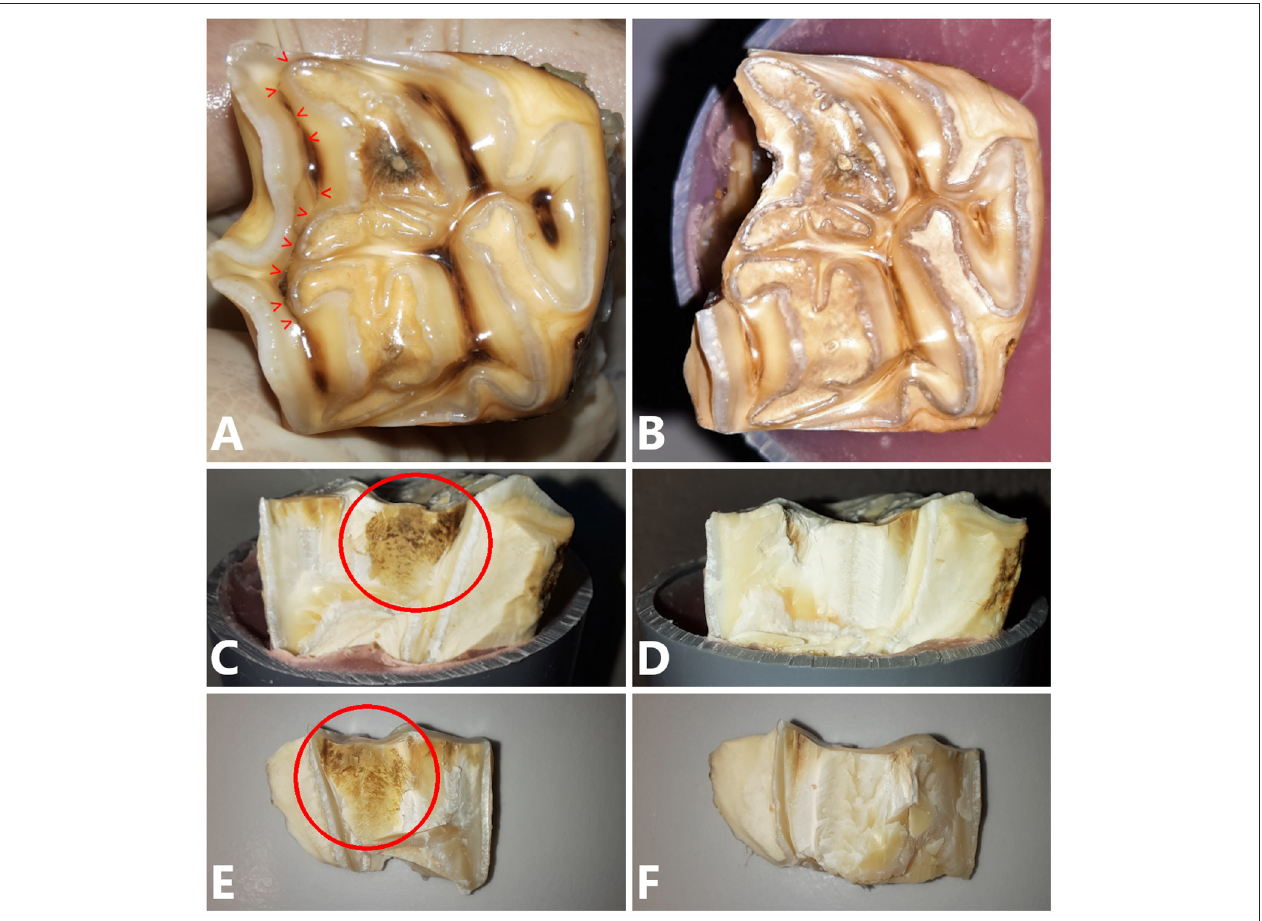
FIGURE 8 | (A) Occlusal view of a 109 cheek tooth with a type 1b fissure present (red arrow heads). Pressure was exerted at the level of SD-PH 1. (B) Occlusal view of the tooth after fracture testing. The fracture followed the path of the fissure approximating SD-PH 2. (C) Lateral view of the tooth after fracture testing. A brown discolored area is visible (red circle) as well as on the fracture fragment (E) . (D,F) No discoloration was visible on the tooth and fragment of the matched control